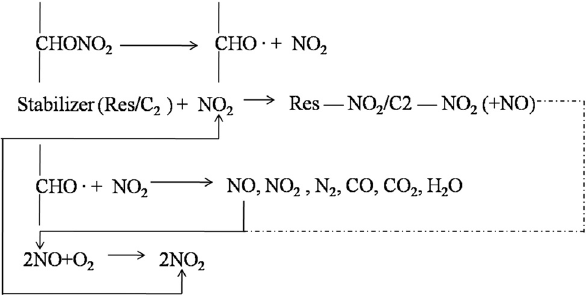
Figure 5: The aging decomposition of NG - NC in GaTo propellants.